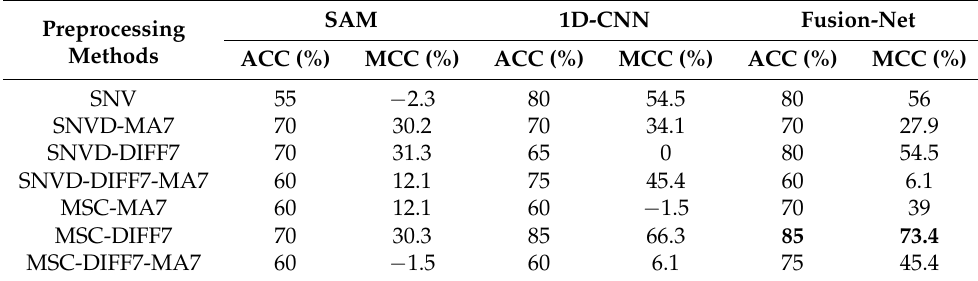
Table 1. Classification results of blueberry firmness from three classification models of SAM, 1D-CNN, and Fusion-Net with seven preprocessing methods. ACC and MCC indicate classification accuracy and Matthew’s correlation coefficient for the test